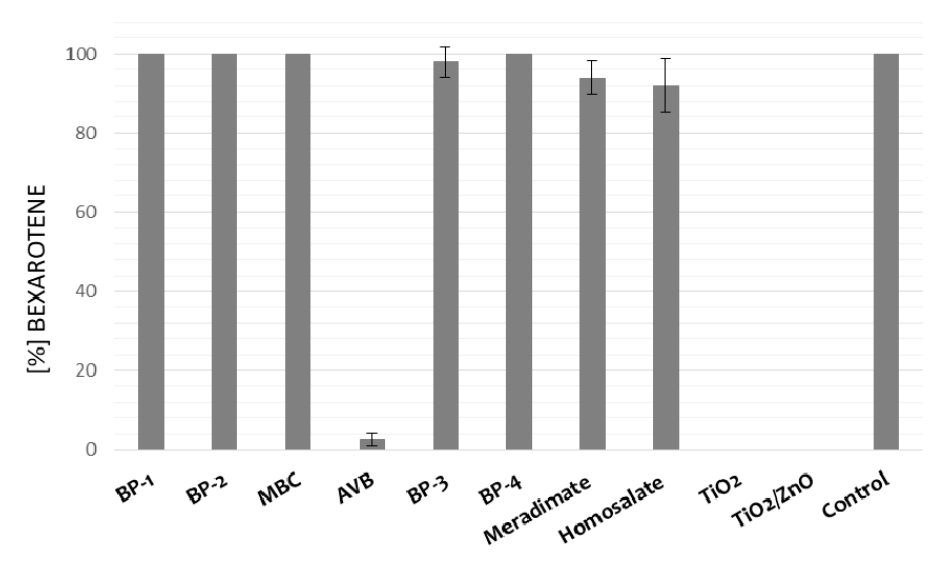
Figure 4. Percentage bexarotene content after 2 h UV irradiation of gel samples containing the investigated substance at 1 mg g − 1 concentration and the tested chemical and physical filters .